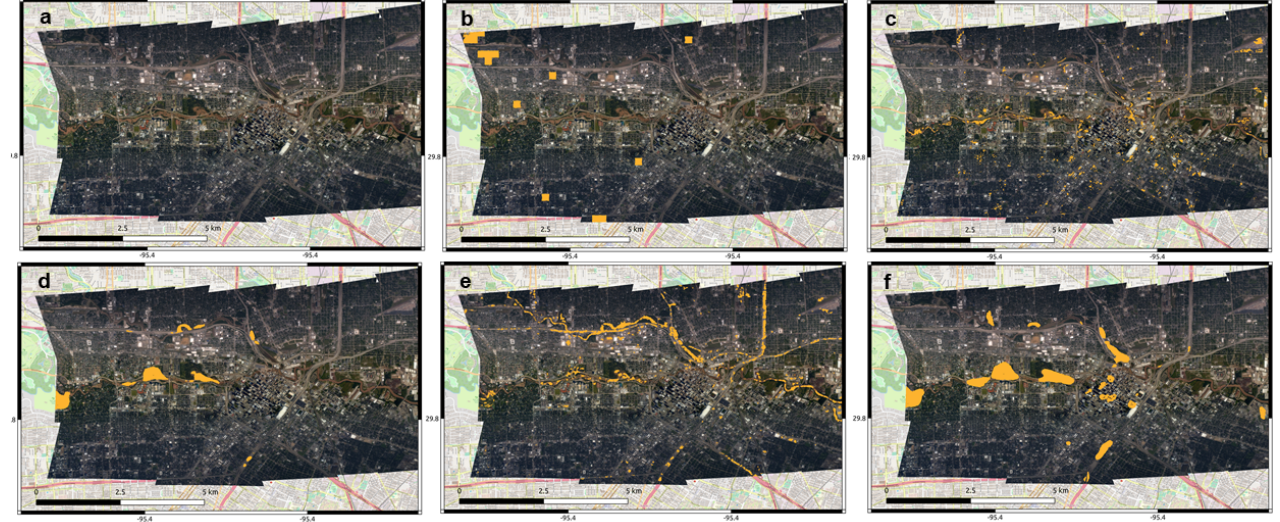
Figure 13. ( a ) NOAA Remote Sensing Division airborne digital optical imagery of the Houston area acquired between 27 August and 3 September 2017, subregion 3, as shown in Figure 2; ( b ) water pixels identified by MODIS data, 250 m pixel spacing, courtesy of the DFO [41]; ( c ) water pixels identified from NDWI analysis of Sentinel-2 data, 10 m pixel spacing; ( d ) water pixels identified by the DeepLabv3+ analysis of SAR GRD data, 29 August 2017, 10 m pixel spacing; ( e ) water pixels identified from thresholding analysis of the same SAR GRD data, 10 m pixel spacing; and ( f ) water pixels identified by the classification analysis of the SAR GRD data, 10 m pixel spacing. The GWM is not removed from the analyses of ( b ) through ( f ). Water pixels are shown in orange.